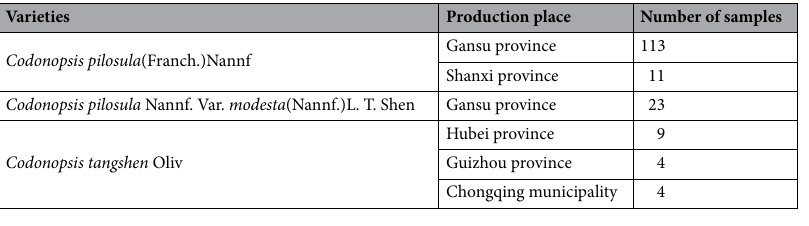
Table 4. Information of